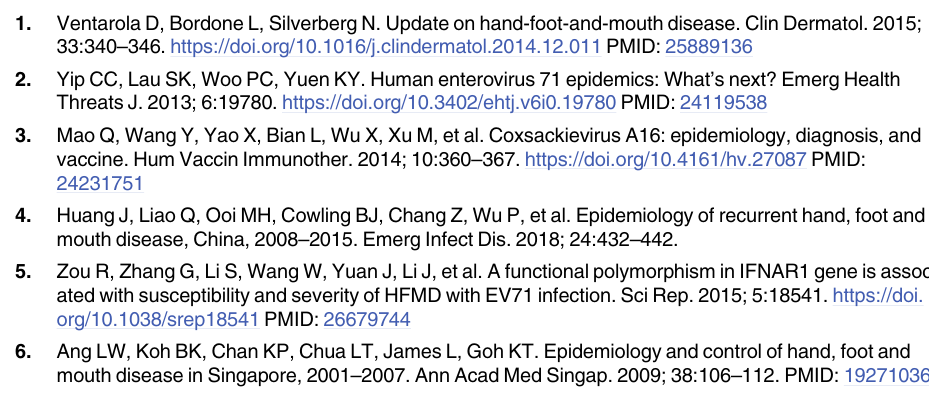
S1 Table. Clinical data in 120 EV71-HFMD cases and 60 healthy control cases. S2 Table. DDX58 network functional analysis. S3 Table. IFIH1 network functional